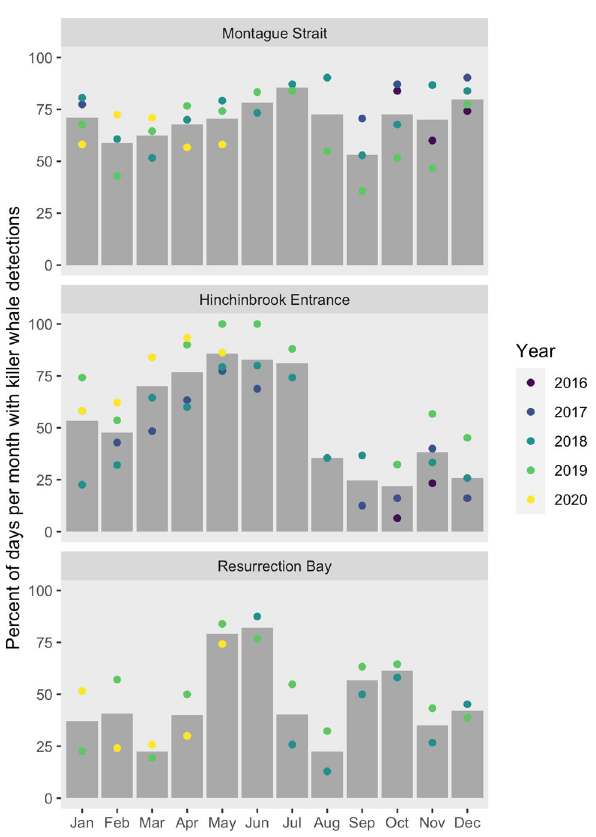
Figure 2. Percent of days per month that killer whales were detected at Montague Strait, Hinchinbrook Entrance, and Resurrection Bay, Gulf of Alaska, October 2016 to May 2020. Columns represent the average across years at each location, colored points represent values for each year recordings were